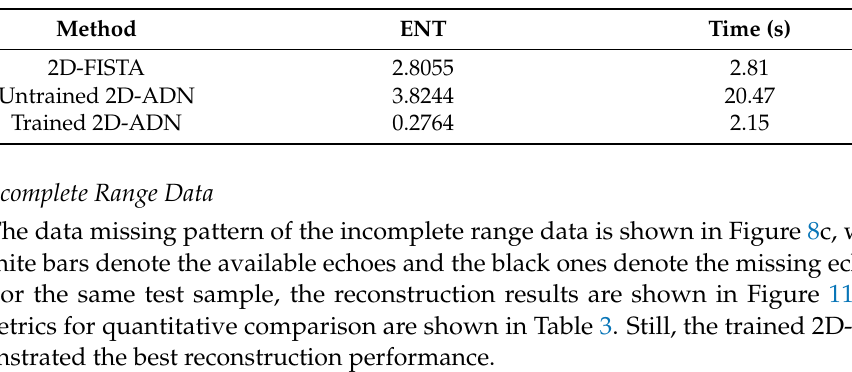
Figure 10. Yak ‐ 42 images of complete data obtained by ( a ) 2D ‐ FISTA, ( b ) untrained 2D ‐ ADN, and Figure 10. Yak-42 images of complete data obtained by ( a ) 2D-FISTA, ( b ) untrained 2D-ADN, and ( c ) trained 2D ‐ ADN. ( c ) trained 2D-ADN. Table 3. Quantitative performance evaluation for the complete measured data. Table 2. Quantitative performance evaluation for the complete measured data.